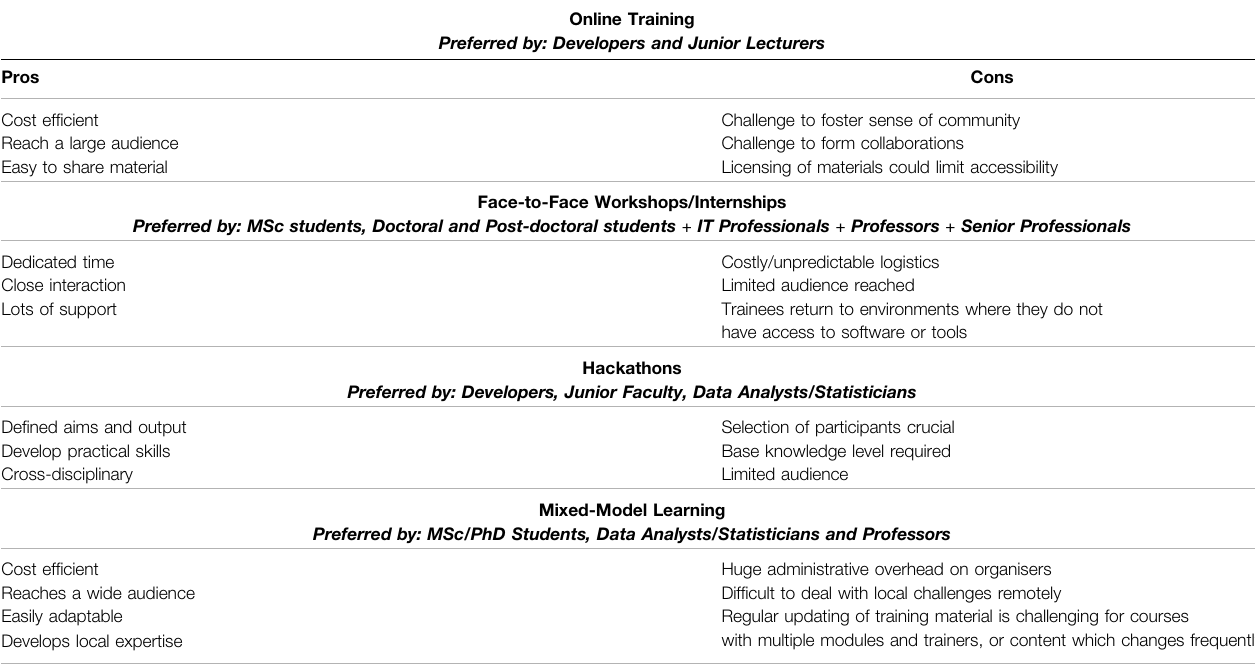
TABLE 1 | A description of the various training modalities preferred by the diverse audience types, highlighting the advantages and disadvantages associated with each modality. Online Training Preferred by: Developers and Junior